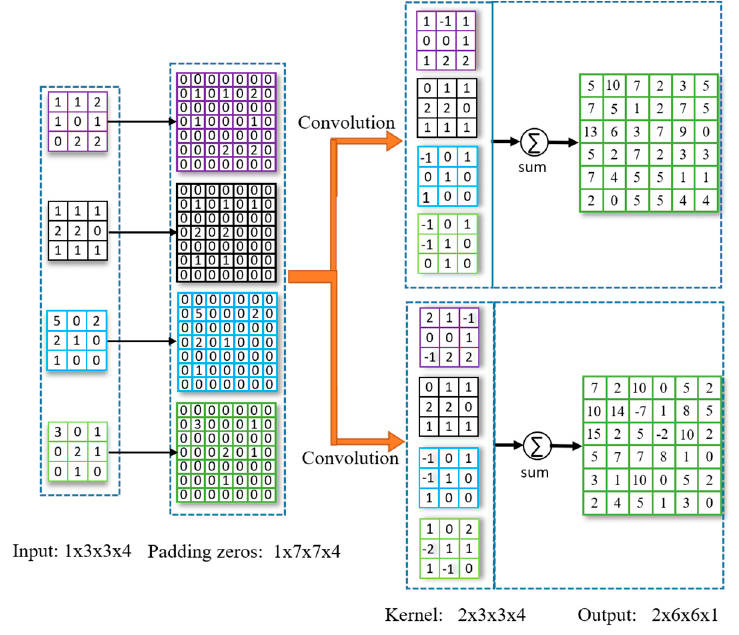
Figure 5. The principle of deconvolutional operation.